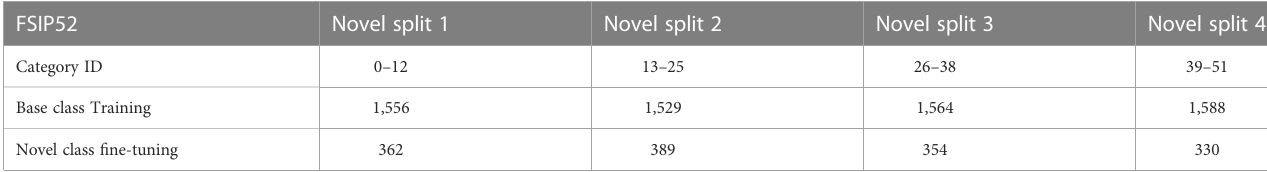
TABLE 1 Detailed FSIP52 data set split experimental settings.